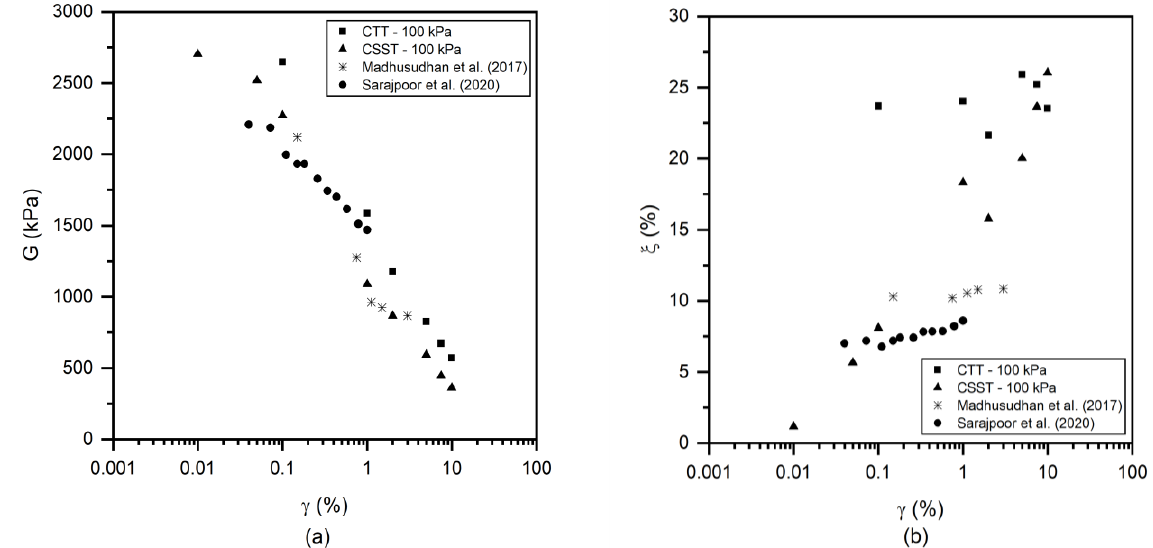
Buildings 2021 , 11 , x FOR PEER REVIEW Figure 10. Comparisons of the ( a ) shear moduli and ( b ) damping ratios obtained from the CTTs and CSSTs in this study, with those from Madhusudhan et al. [30] and Sarajpoor et al. [23].